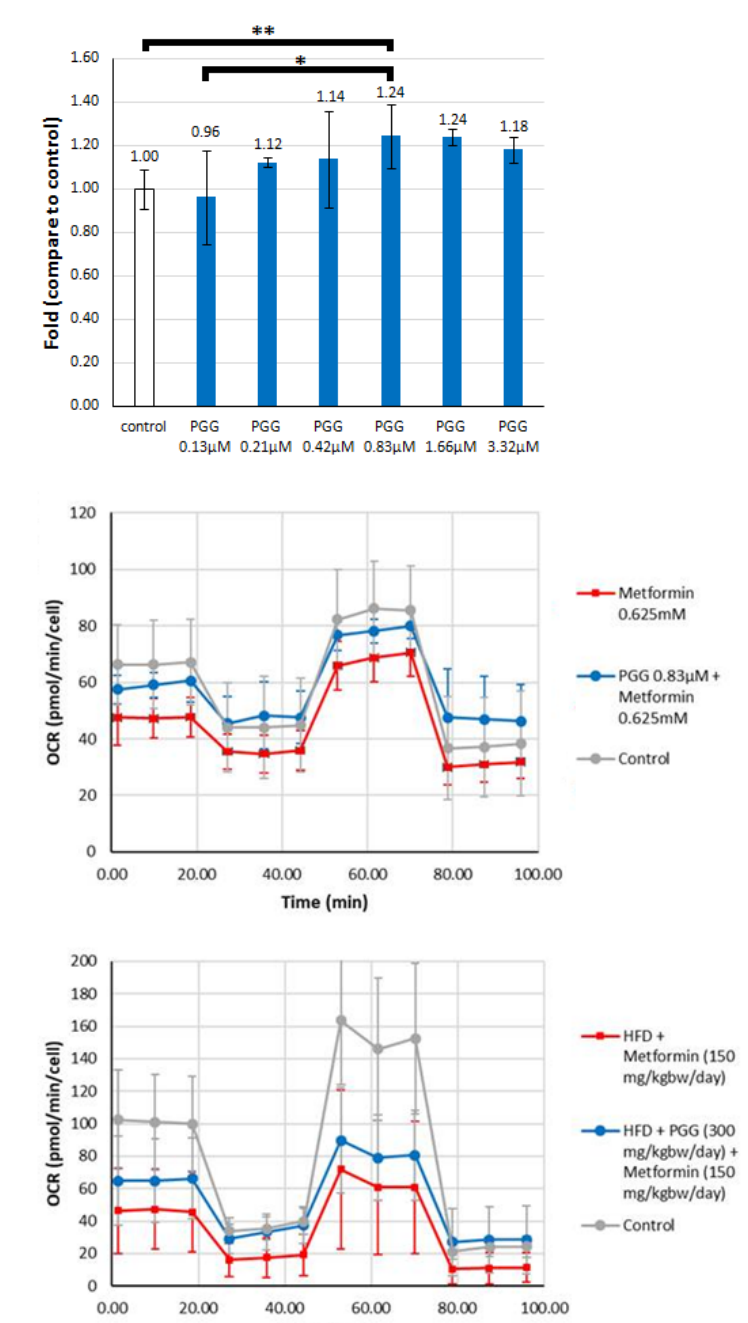
Figure 5. The rescue effect of PGG in metformin-induced oxygen consumption rate (OCR) decrease was evaluated by Seahorse analysis using in vitro and in vivo models. ( A ) The OCR maximum capacity in Mahlavu cells treated with different doses of PGG. ( B ) Mitochondrial respiration reflected by OCR levels was detected in Mahlavu cells treated with metformin alone and treated with met- formin combined with PGG, respectively. ( C ) Mitochondrial respiration reflected by OCR levels was detected in mouse primary hepatocytes obtained from HFD-induced NAFLD mice treated with metformin alone and treated with metformin combined with PGG, respectively. (* p < 0.05; ** p < 0.01; N = 2/Control group; N = 3/Metformin group and Metformin + PGG group).